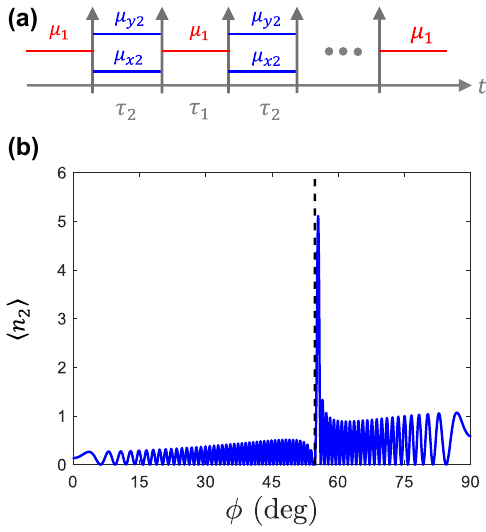
Figure 8: Asymmetric and fast-varying angular amplification lines near a temporal Brewster angle. (a) Sketch of a temporal sequence constructed by 501 temporal slabs with material parameters: 𝜀 = ( 𝜋 ∕ 2) ∕ ( kc ) and 𝜏 = ( 𝜋 ∕ 2) ∕ 𝜔 k 0 2 . Inhibition of photon 1 2 = 54.74 deg, while resonant production takes place near 𝜙 B = 55 deg. (b) Photon production as a amplification takes place at 𝜙 0 function of the observation angle 𝜙 . The results show an asymmetric angular line arising from the interaction between the Brewster angle and the coherent